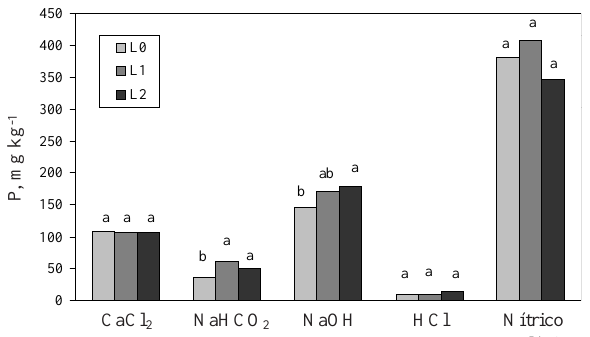
Figura 1. Extração seqüencial de P em solo (0- 0,05 m) nas doses L0, L1, e L2, 234 dias após aplicação do lodo (primeiro ano). Letras diferentes representam diferença estatística a 5 % pelo teste